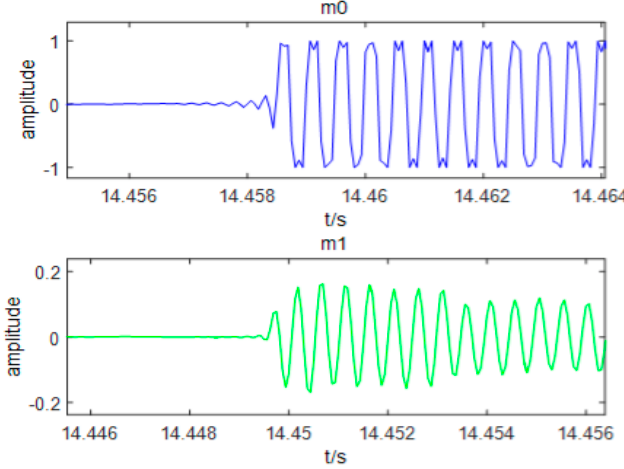
Figure 2. A part of a sound signal waveform received by two microphones (m0 and m1). The sound